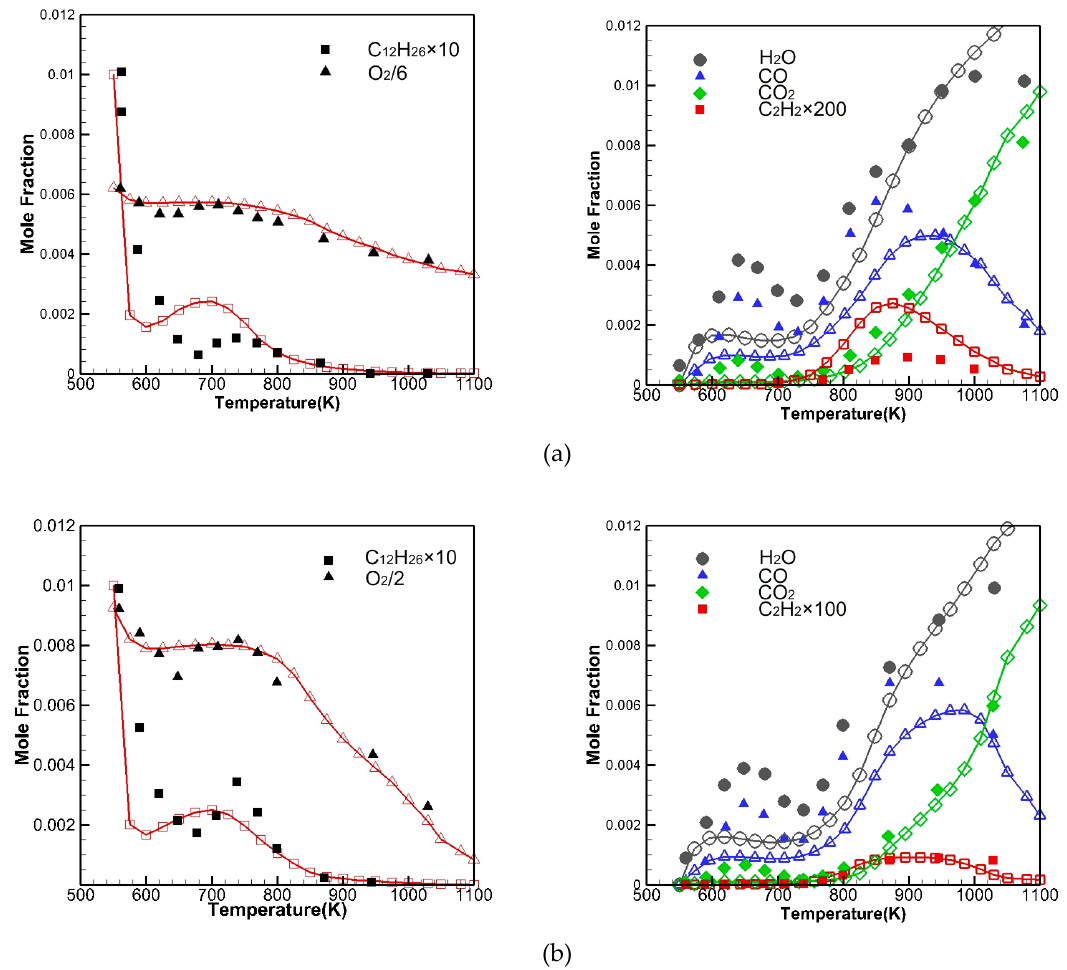
Figure 9. Comparison of simulation (lines with hollow symbols) and measured [27] (solid symbols) major species concentration at (a) φ =0.5 and (b) φ =1.0 in JSR.